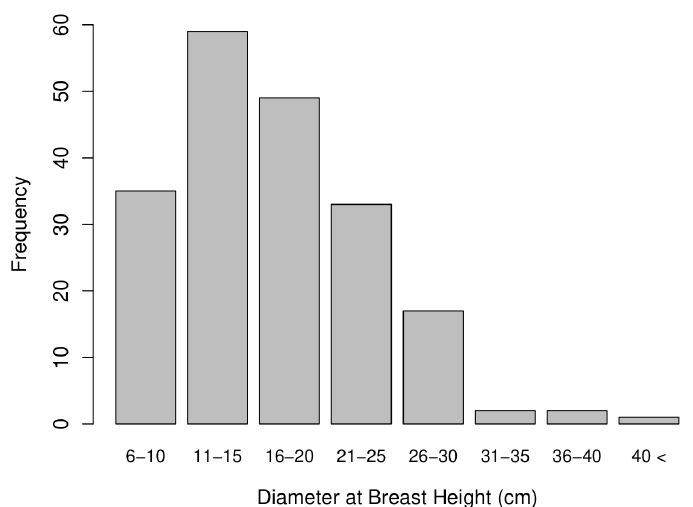
Figure 4. Frequency histogram of DBH in 2007, the year with the most complete data. The distribution of DBH did not change significantly over the period of the study.